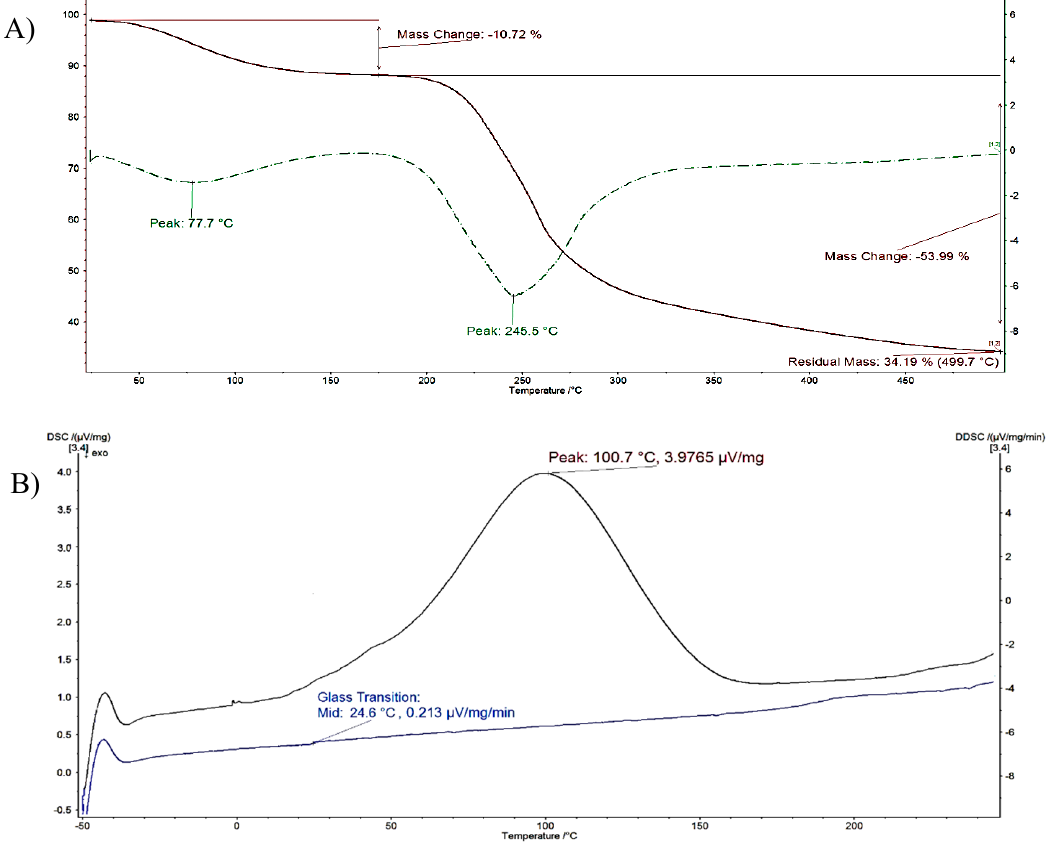
Figure 5. Typical thermal analysis results for P-OX4: ( A ) Thermogravimetric analysis (TGA) thermogram (first derivative thermogravimetry (DTG) represented as dotted line); and ( B ) Differential scanning calorimetry (DSC) curves: First run—top, and second run—bottom).